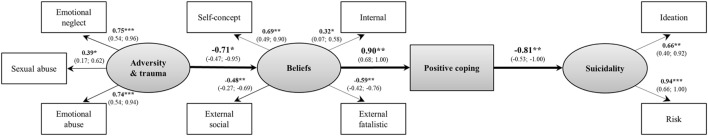
Psychological mediators between childhood adversities/trauma and suicidality. Model fit indices: χ2(33) = 43.41, p = 0.106; Comparative Fit Index = 0.90; Tucker–Lewis Index = 0.87; root-mean-square error of approximation = 0.06, p = 0.300; Weighted Root Mean Square Residual = 0.61. Standardized indirect effect, IE = 0.54; 95% confidence intervals (Cis) = 0.27; 0.82; p = 0.005. Rectangles present observed manifest variables, ovals unobserved latent variables; values are standardized path coefficients and 95% CIs of parameter estimates. *p < 0.05, **p < 0.01, ***p < 0.001.